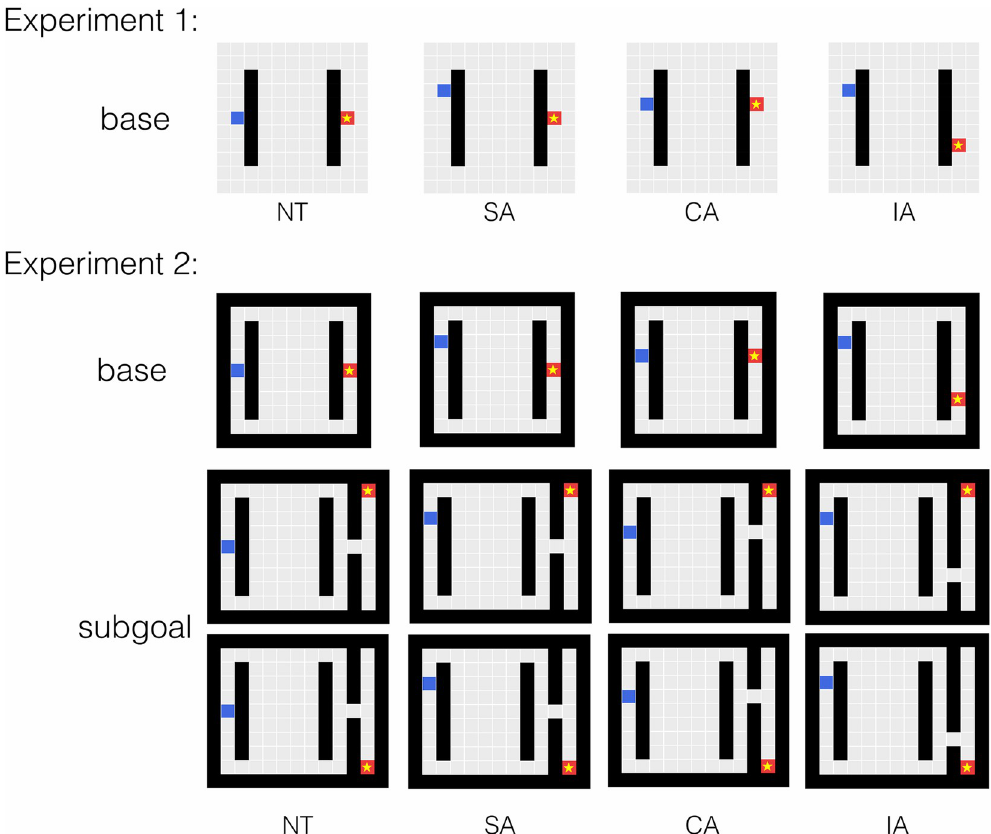
Fig 2. Experimental design. Blue block: starting point. Starred red block: goal location. Trial advantage types are based on the correspondence between the starting-point proximal constraint (myopic advantage) and the goal-/subgoal-proximal constraint (future advantage). NT = neutral advantage, SA = single advantage, CA = congruent advantage, IA = incongruent advantage. For the subgoal trials in Experiment 2, both of the possible final goal locations are shown.